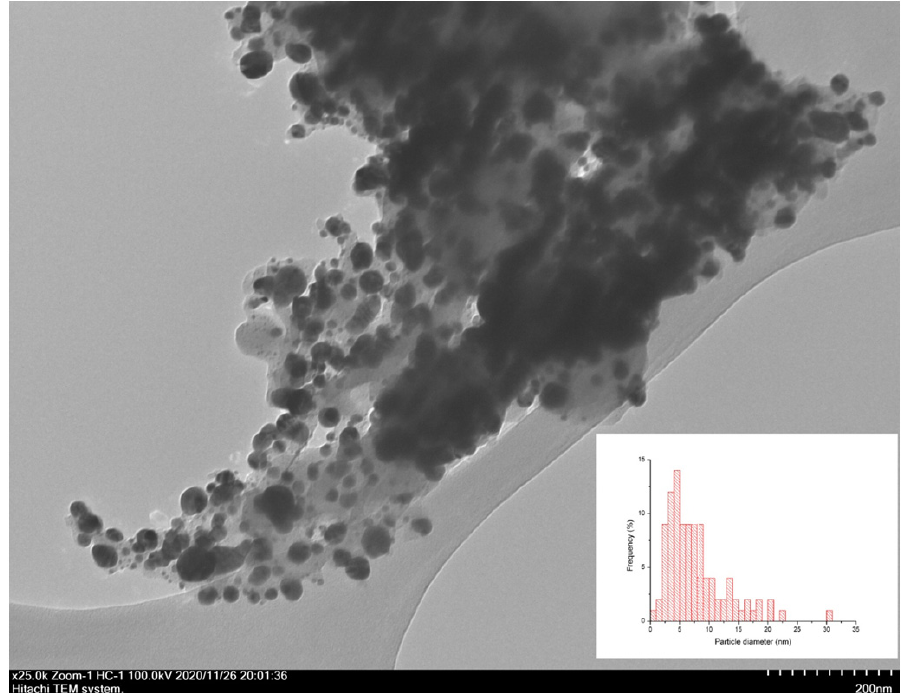
Figure 4. Bright field TEM image of the surface of BCP-Ag composite, obtained by plasma treatment of the BC and subsequent Ag nanoparticle deposition. In the right bottom corner is a histogram of the nanoparticles’ size distribution.